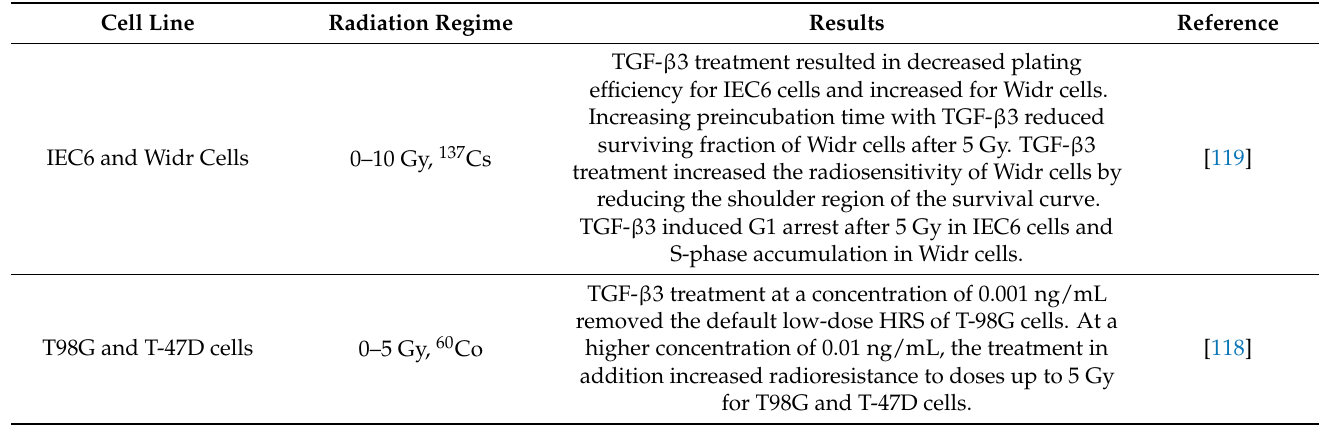
Table 3. Studies of treatment with exogenous TGF- β 3 in combination with irradiation in vitro. HRS: